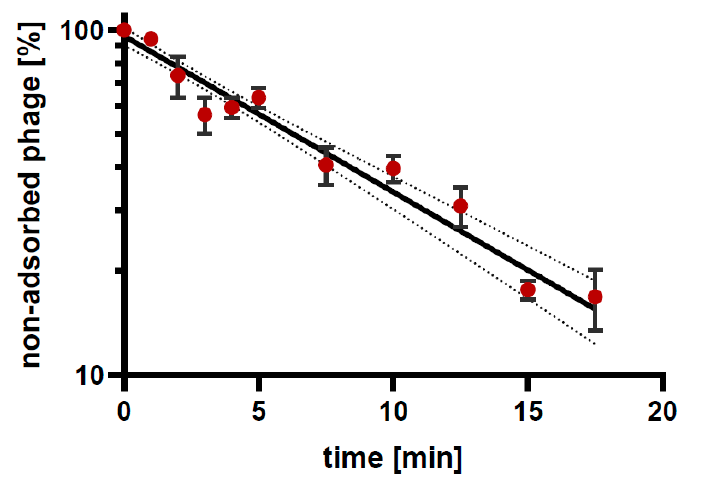
Figure 3. Kinetic of Acba_6 adsorption on A. baumannii 3940 at MOI = 0.1. Points represent an average; error bars represent the standard deviation of the mean phage titers for three samples (± SD). Lines correspond to the model (linear regression) used to calculate the adsorption constant; dotted line is the 95% confidence interval (CI). Table 5. Adsorption rate constants [mL/min] for 12 Acinetobacter -specific bacteriophages.